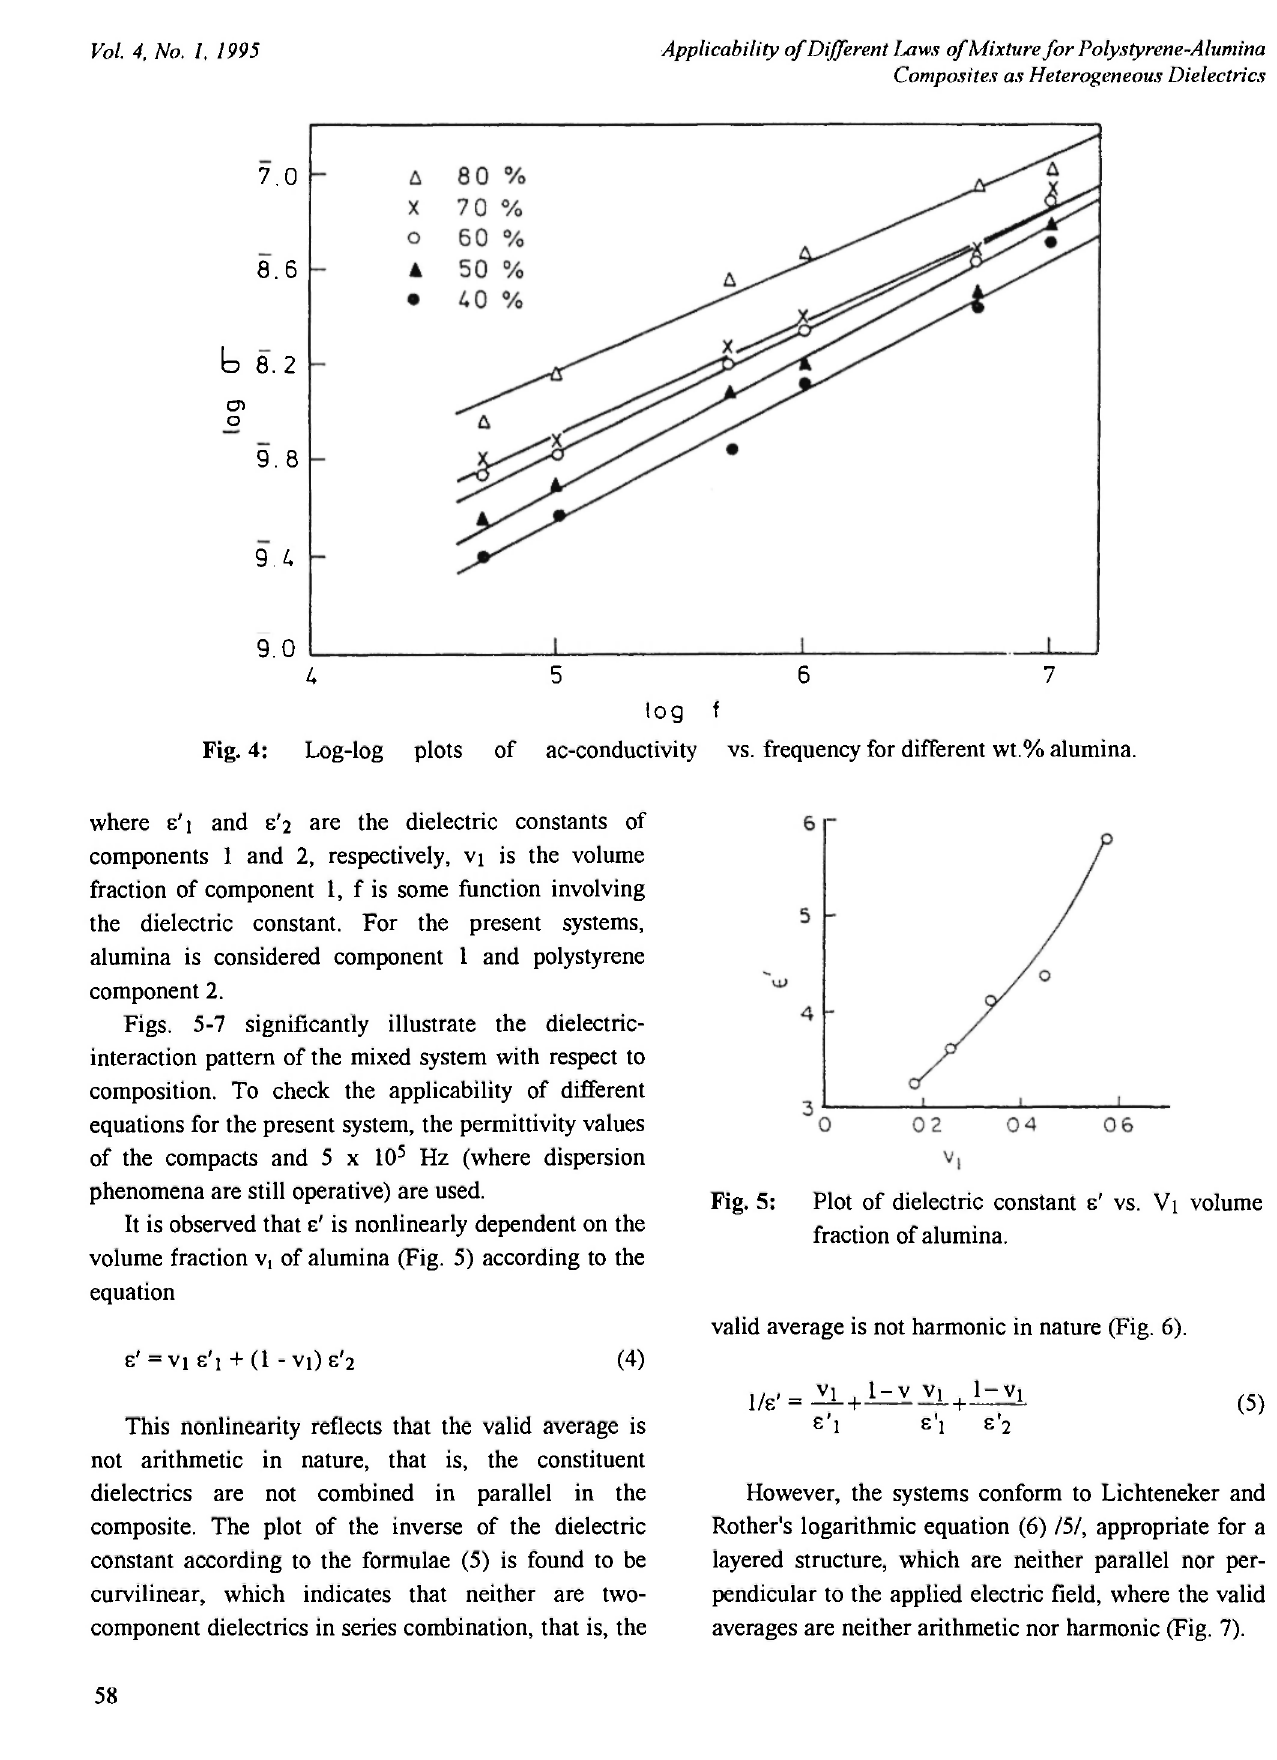
Fig. 4: Log-log plots of ac-conductivity vs. frequency for different wt.% alumina.